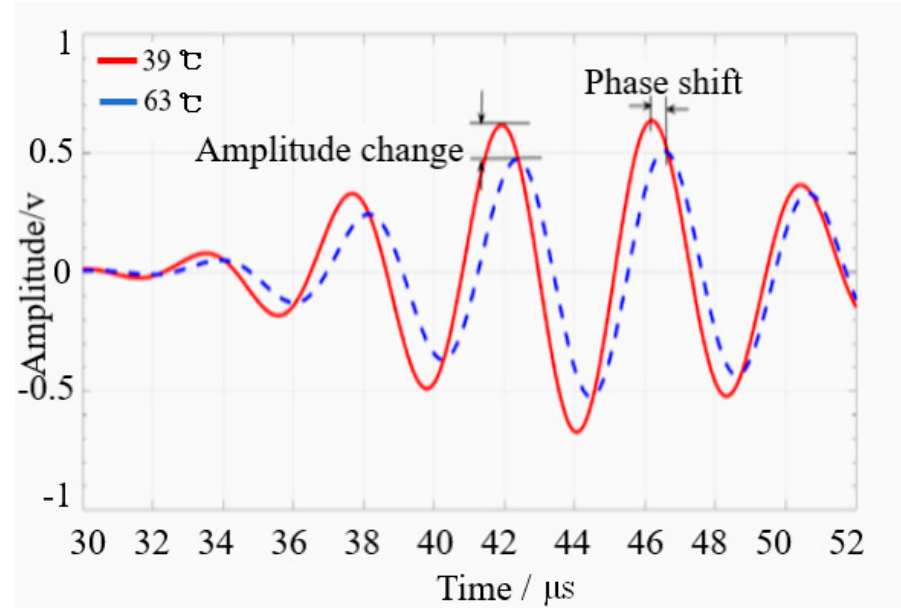
Figure 13. Typical signal differences under different temperatures [5].